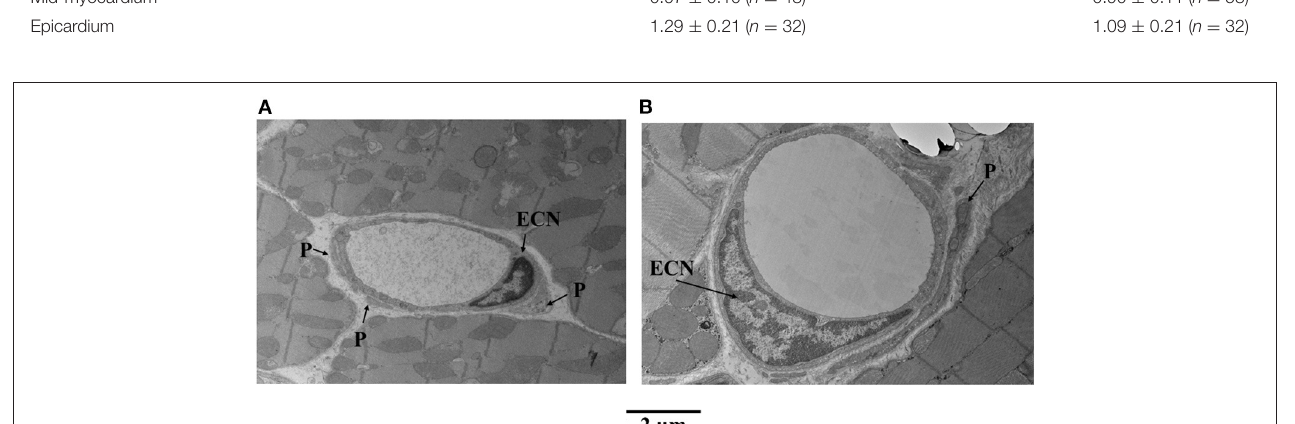
FIGURE 6 | Examples of capillaries and pericytes (P) from the mid-myocardium of a dog, where MVR decreased even more during adenosine infusion [2.45 to 0.69 mmHg · (mL · min) − 1 ]. (A) Shows a capillary from a bed not receiving adenosine, and (B) shows a capillary from a bed receiving adenosine. The capillary area is larger in the latter (B) . In both examples, endothelial cell nuclei (ECN) are also present as are pericyte processes.